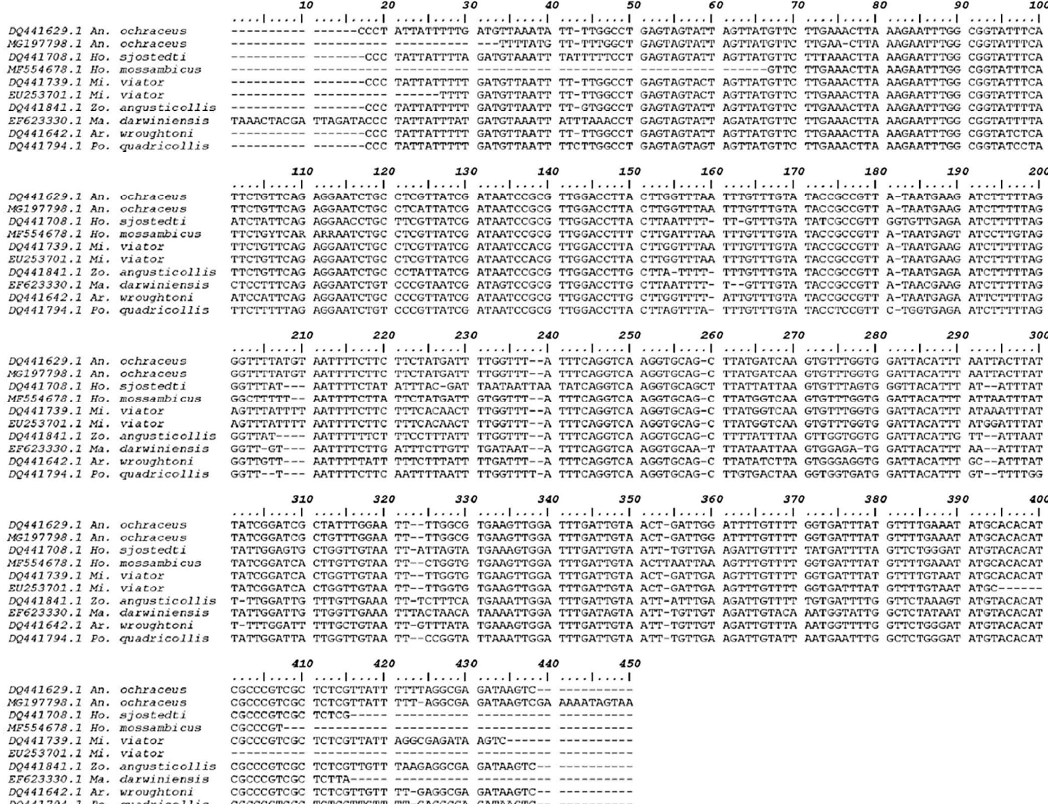
Figure 2. Molecular phylogenetic analysis by maximum likelihood based on the Tamura-Nei model. The tree with the highest log likelihood − 2940.2934) is shown. The percentage of trees in which the associated taxa clustered together is shown next to the branches. The initial tree(s) for the heuristic search were obtained automatically by applying the Neighbor-Join and BioNJ algorithms to a matrix of pairwise distances estimated using the maximum composite likelihood (MCL) approach, and then selecting the topology with superior log likelihood value.